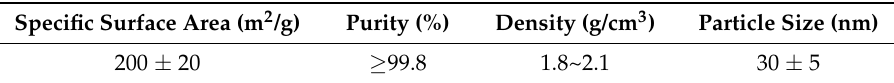
Table 1. Properties of